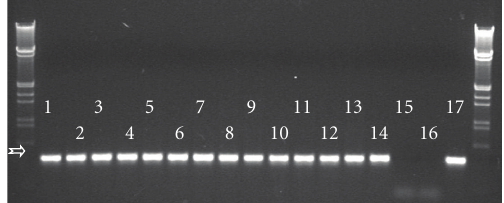
Figure 2: Detection of RNA transcripts derived from the herbicide resistance gene bar by electrophoresis of RT-PCR products. The white arrow shows the expected 375bp fragment. Markers: λ -DNA digested with EcoRI and HindIII restriction enzymes. Samples from left to right: 1–14: according to increasing herbicide concentrations (1 refers to 0 while 14 refers to 5000 mg · L − 1 of glufosinate ammonium), 15: nontransgenic CY-45 plant, 16: distilled water, 17: pAHC25 plasmid